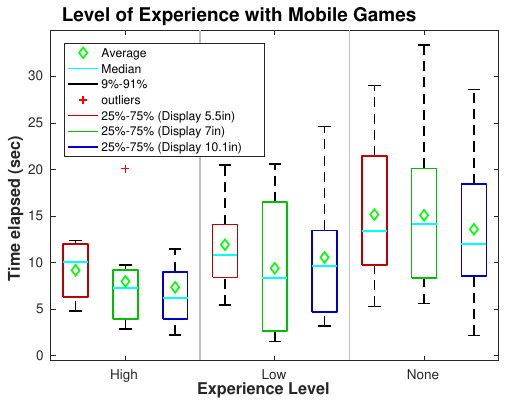
Figure 5. Results of the analysis considering groups of volunteers according to their experience with mobile games.